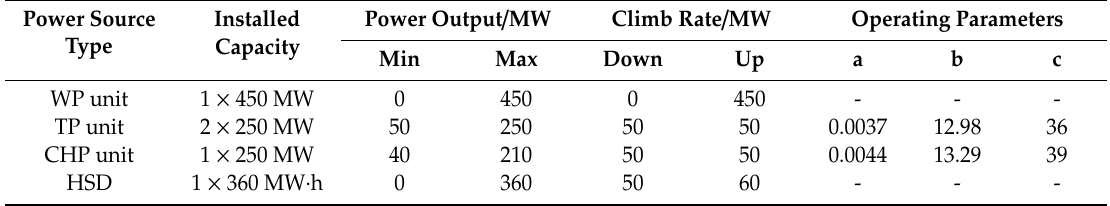
Table A3. The parameters of